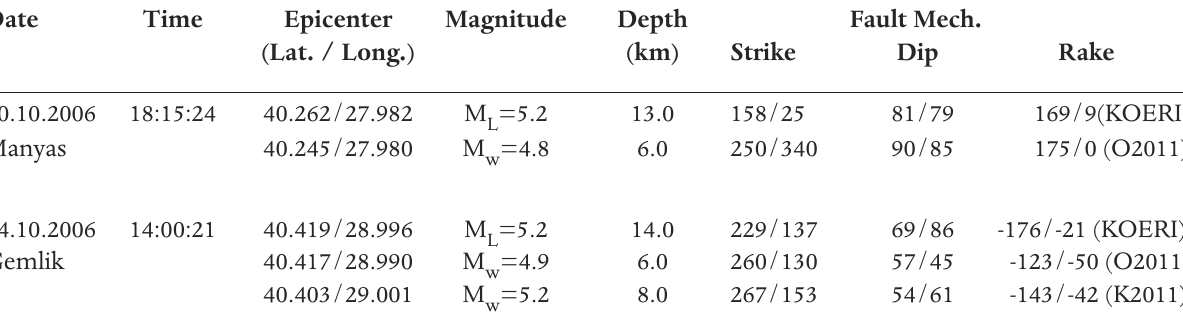
Table 1. Parameters of the Manyas and Gemlik earthquakes. KOERI: Kandilli Observatory and Earthquake Research Institute,